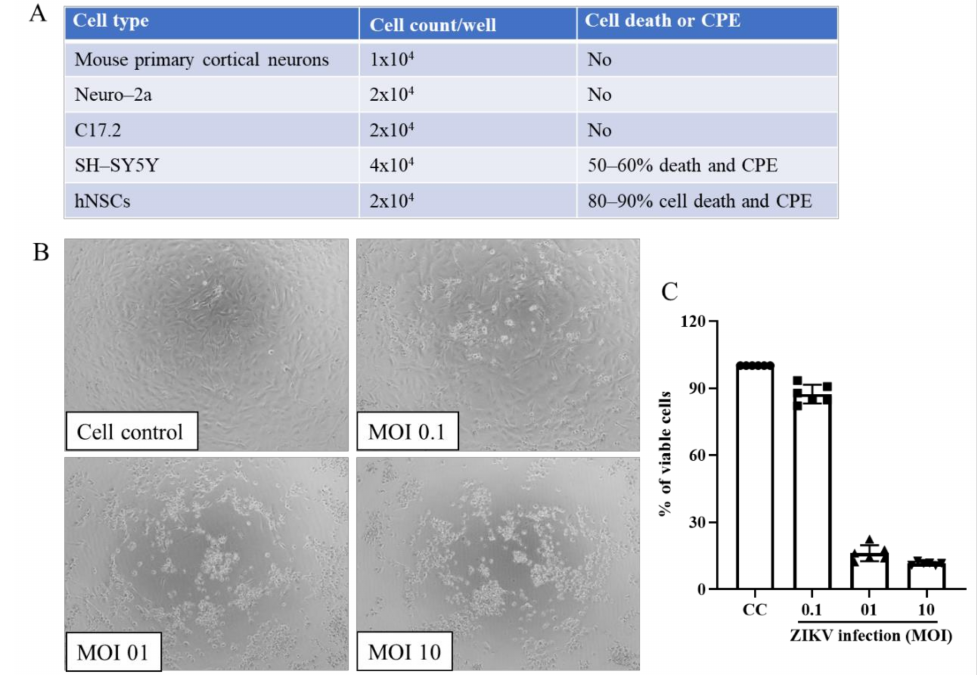
Figure 1. Selection of appropriate cell lines and virus MOI for ZIKV infection. ( A ) Screening of multiple neuronal cell lines against ZIKV infection. ( B ) Light microscopic images of MOI-based ZIKV induced cytopathic effect (CPE) on hNSCs. ( C ) MOI-dependent cytotoxicity of ZIKV infection by MTT assay. Each bar represents the mean ± SD of two independent experiments with three replicates per